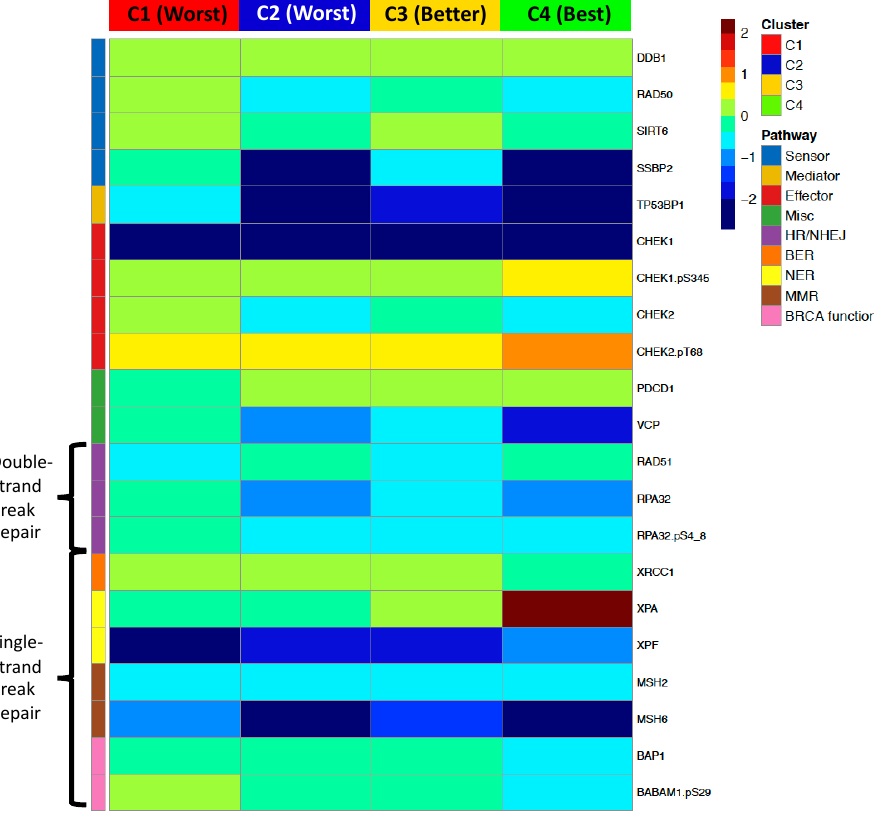
Figure 7. Unique global DDR patterns in patient clusters from Figure 1A. The heatmap displays the median expression of the 21 core DDR proteins for all four clusters from Figure 1A. Proteins downregulated in expression relative to normal CD34+ cells are colored in cooler colors approaching deep blue, while upregulated proteins are colored in warmer colors approaching burgundy. Notations for each protein’s functional role in DDR are displayed on the left side of the